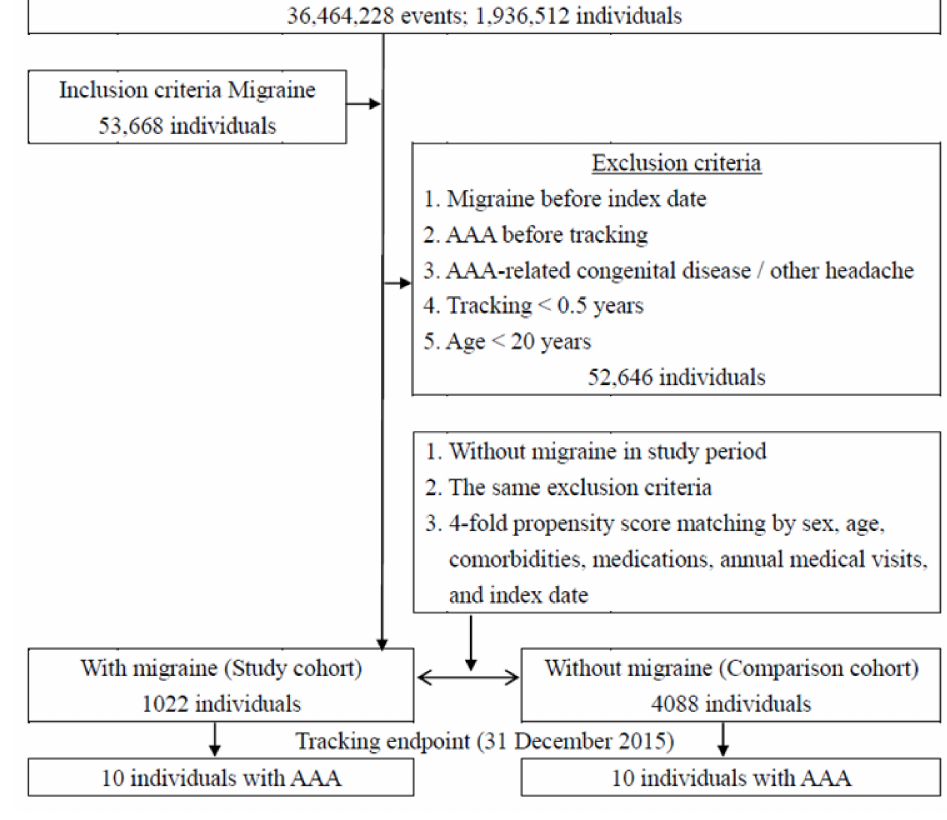
Figure 1. Patient selection